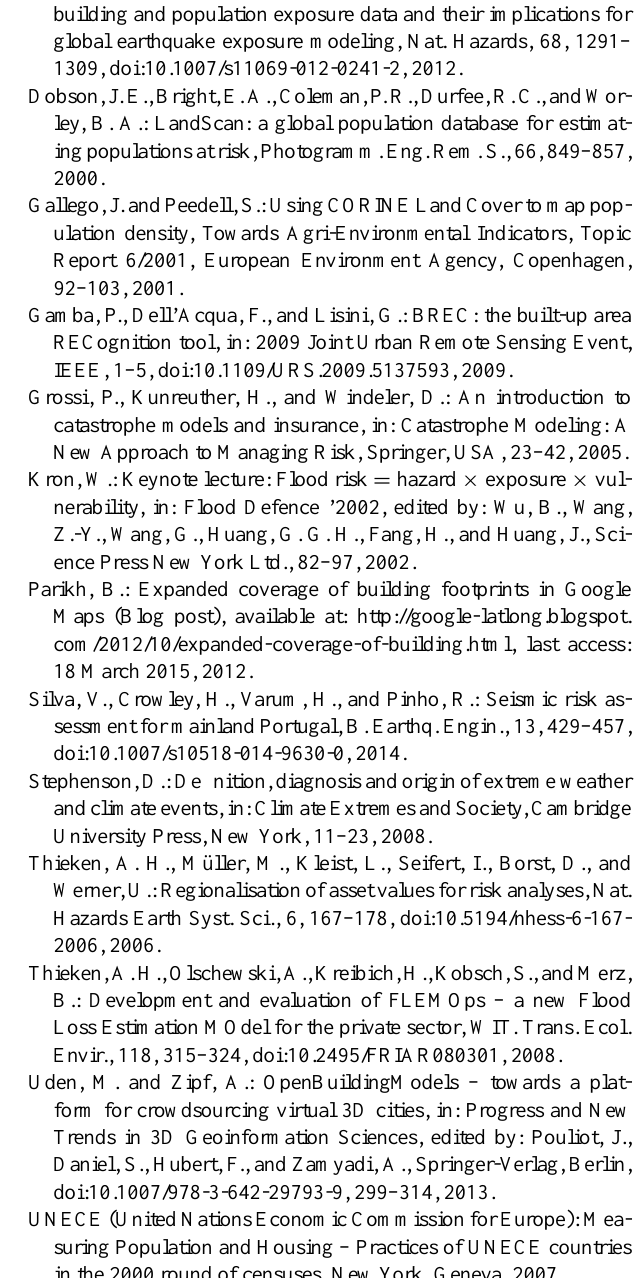
R. Figueiredo and M. Martina: Open building data in the development of exposure data